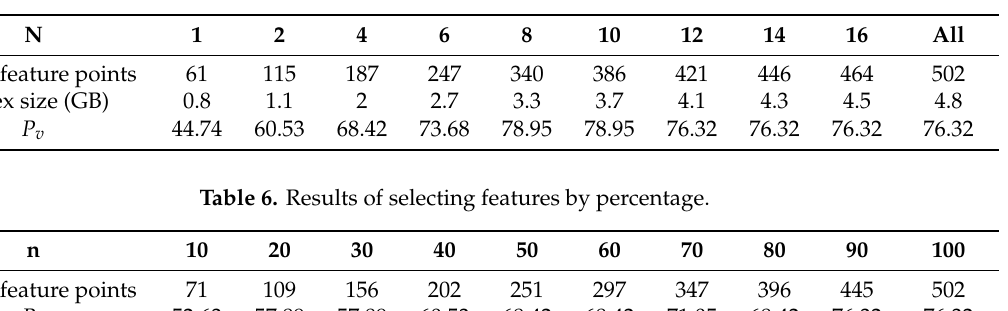
Table 5. Results of selecting features by number.